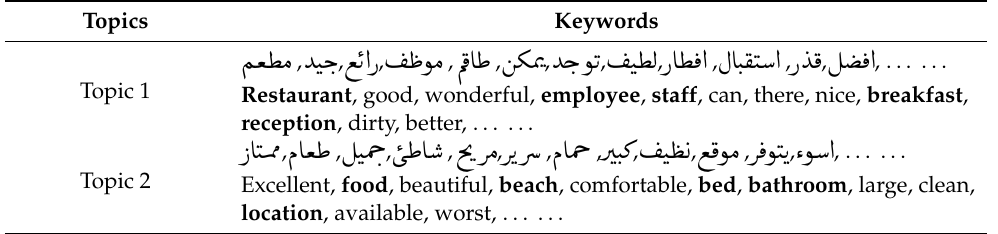
Table 4. Sample of the generated LDA topics and keywords.